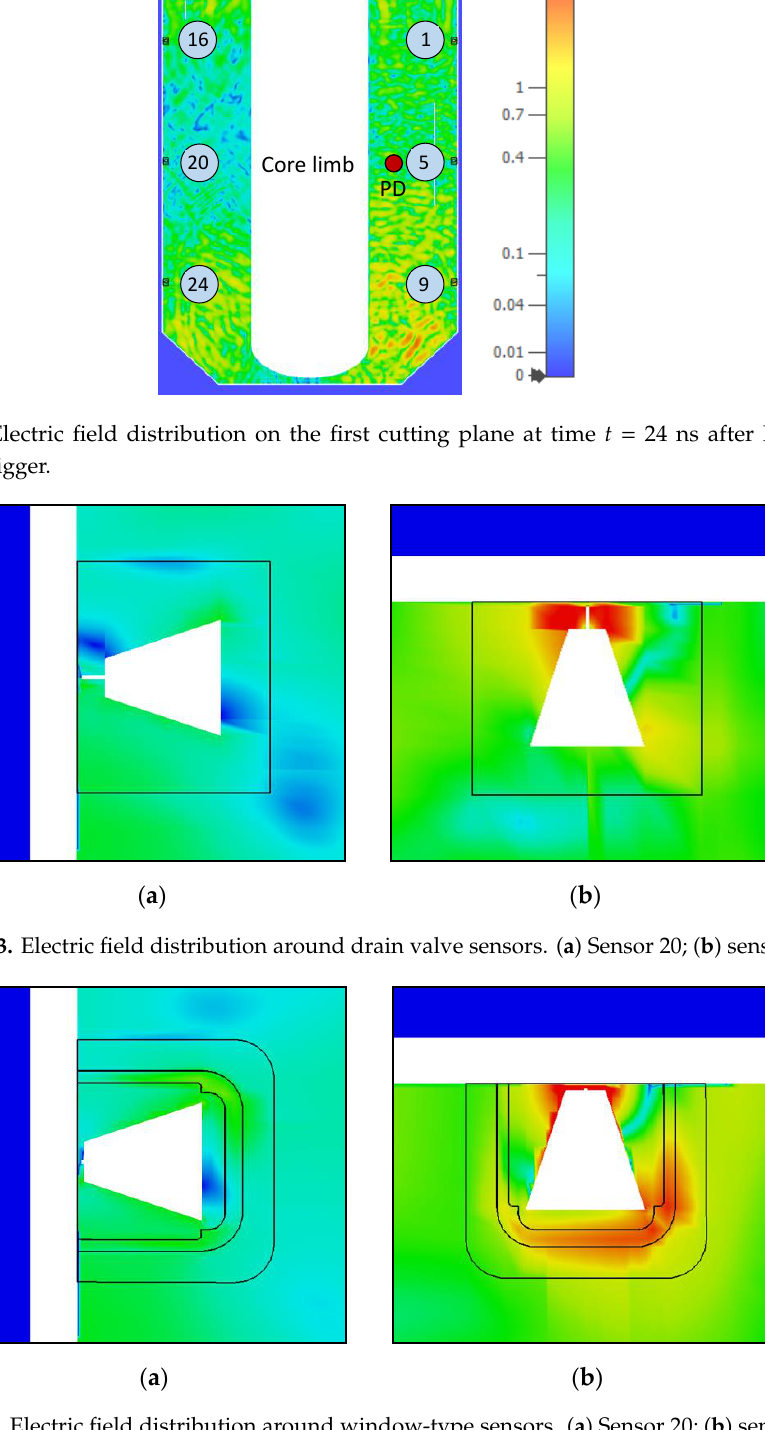
Figure 14. Electric field distribution around window-type sensors. ( a ) Sensor 20; ( b ) sensor 32.